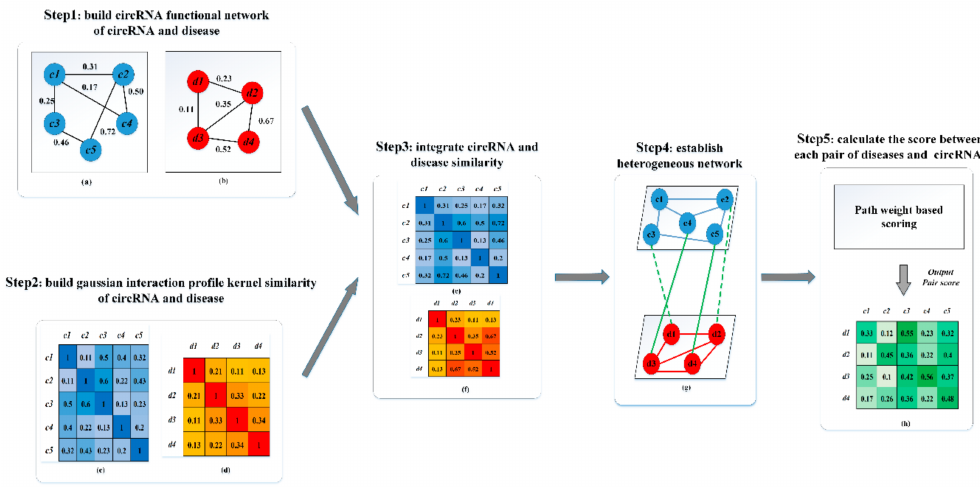
Figure 3. The flowchart of PWCDA is illustrated by five main steps. Step 1: Calculate circRNA semantic similarity and disease similarity scores, respectively. Step 2: Calculate GIP Kernel similarity scores for circRNAs and diseases. Step 3: Integrate circRNA (disease) semantic (functional) similarity with circRNA/disease GIP Kernel similarity, respectively. Step 4: Construct the heterogeneous network. Step 5: Calculate an association score for each circRNA-disease